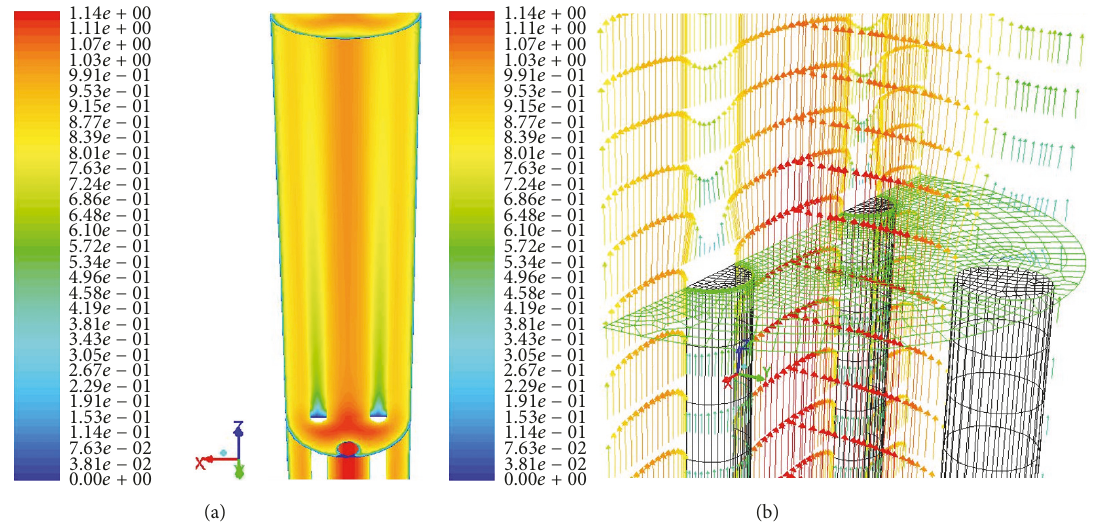
Figure 9: Velocity contour plot [m/s] (a) and vector velocity coloured by z -velocity (b) in the 3D CFD domain, during Step 6 of Test 206.